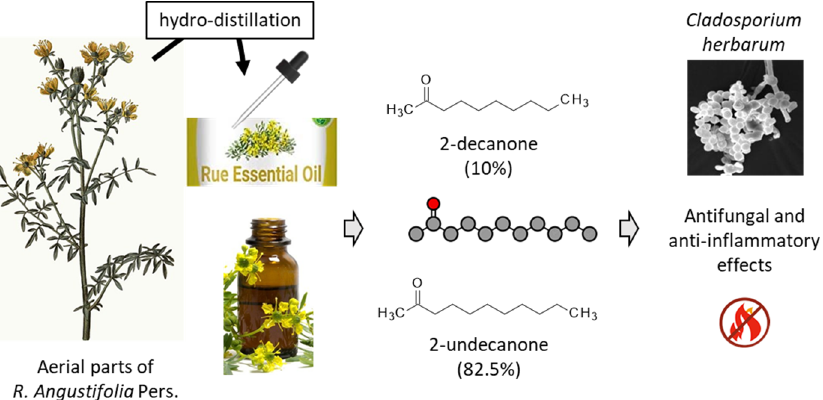
Figure 2. An essential oil manufactured from the aerial parts of Ruta angustifolia Pers. contained essentially 2-ketone derivatives, principally 2-undecanone and 2-decanone, which display antifungal and anti-inflammatory properties [6,16].